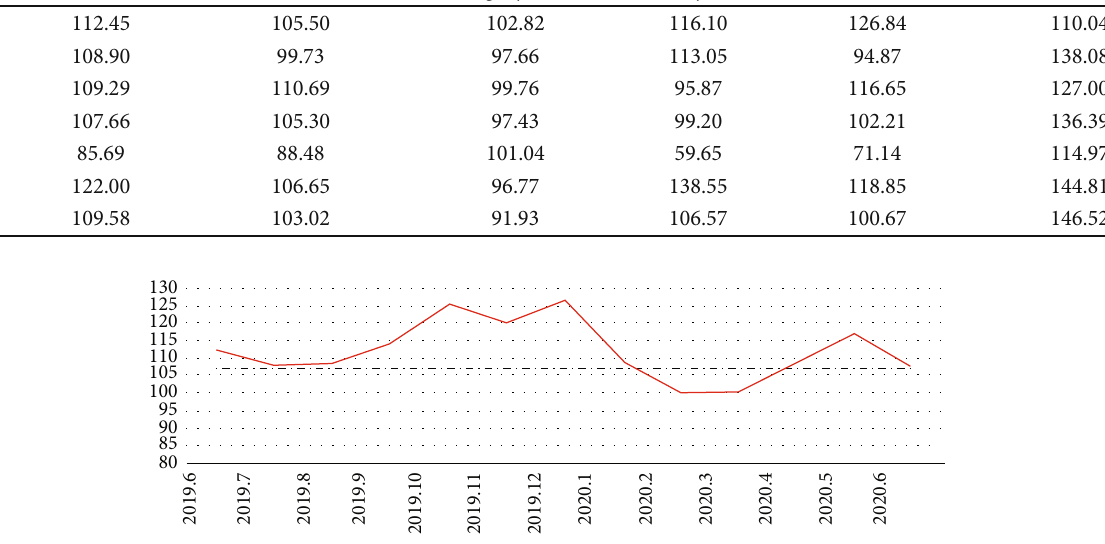
Figure 4: A trend of digital industry progress